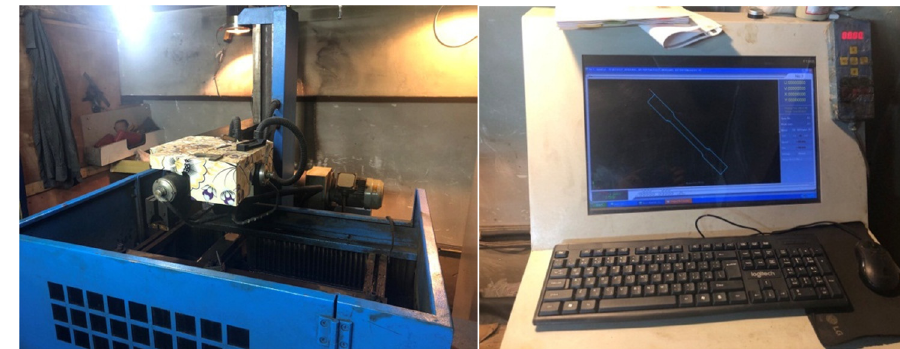
Figure 5: EDM cutting machine.